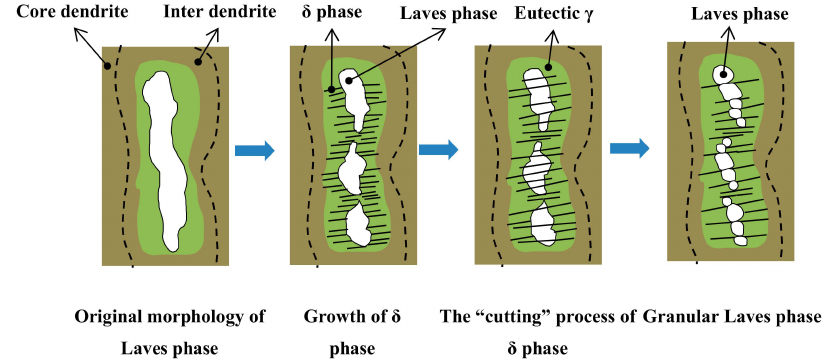
Figure 5. Schematic diagram of the “cutting” and “dissolution” of the Laves phase through the precipitation of the δ